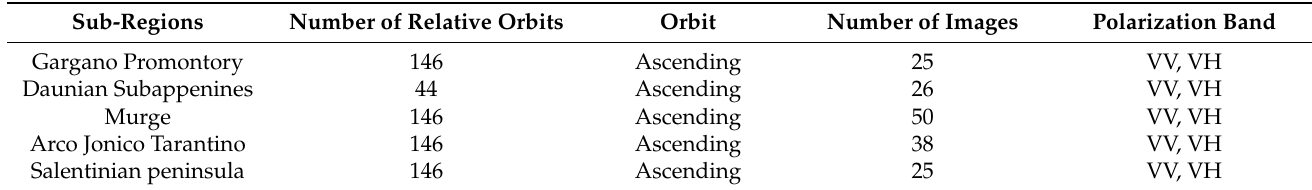
Table 1. List of Sentinel-1 images acquired for the field